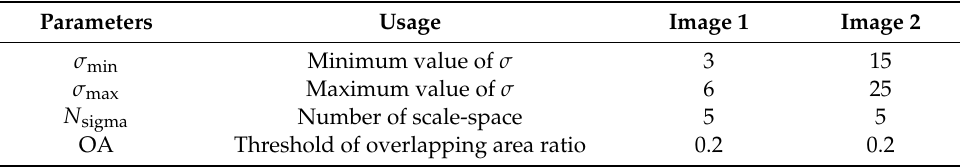
Table 3. Parameters of SSF based tree detection method for two image